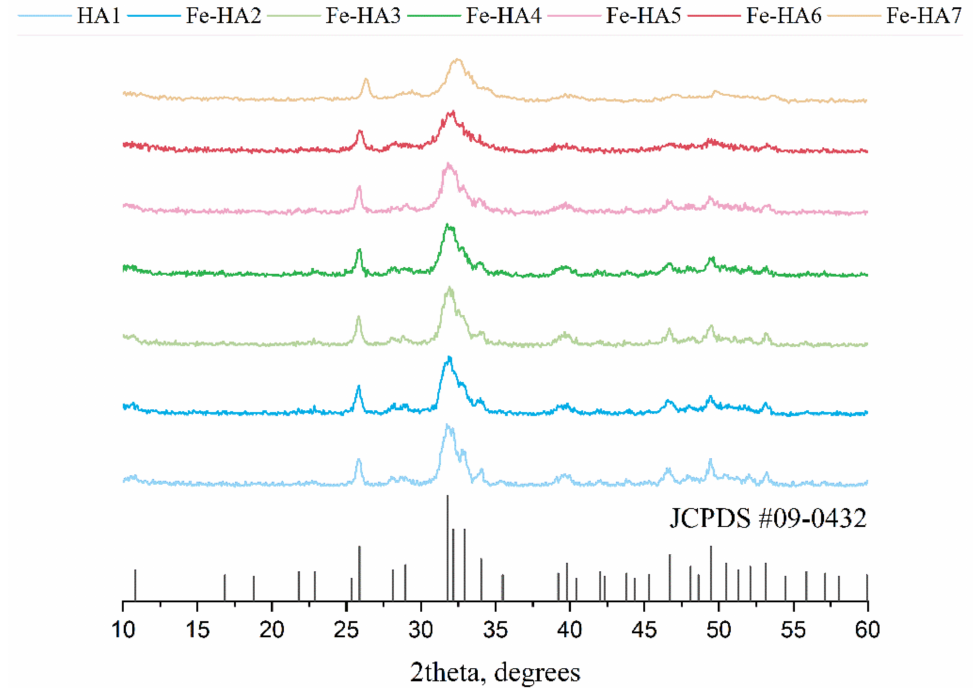
Figure 1. XRD spectra of hydroxyapatite (HA) and Fe-HA powders after the synthesis, JCPDS#09- 0432 corresponds to HA. Table 2. Powders characteristics of the lattice parameters and crystalline